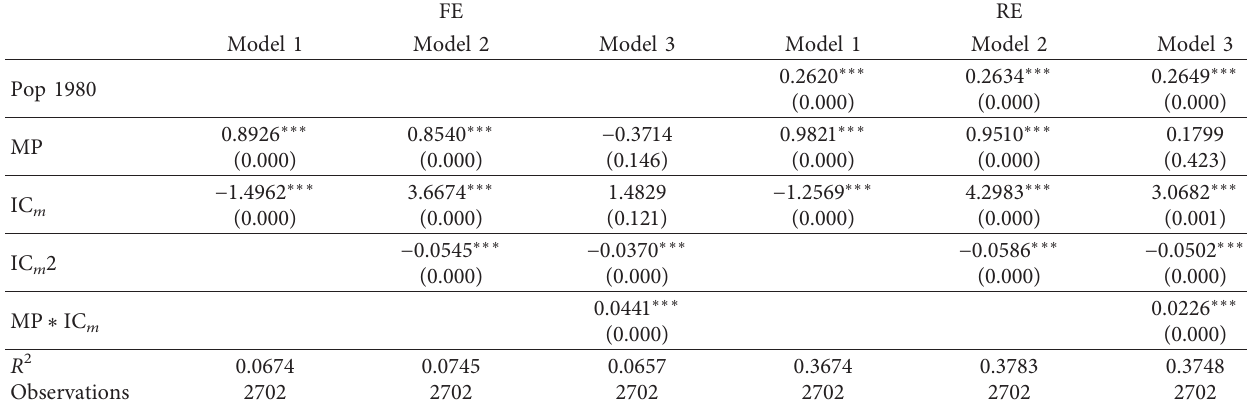
Table 4: Regression results of manufacturing shares, 5-year periods.